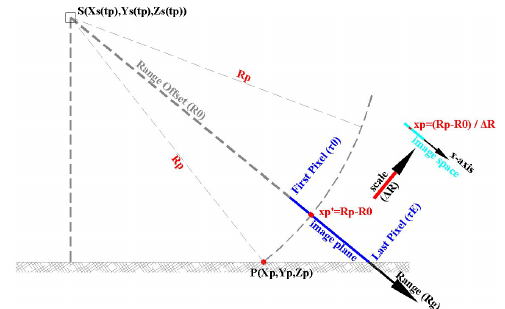
Figure 1. SAR imaging